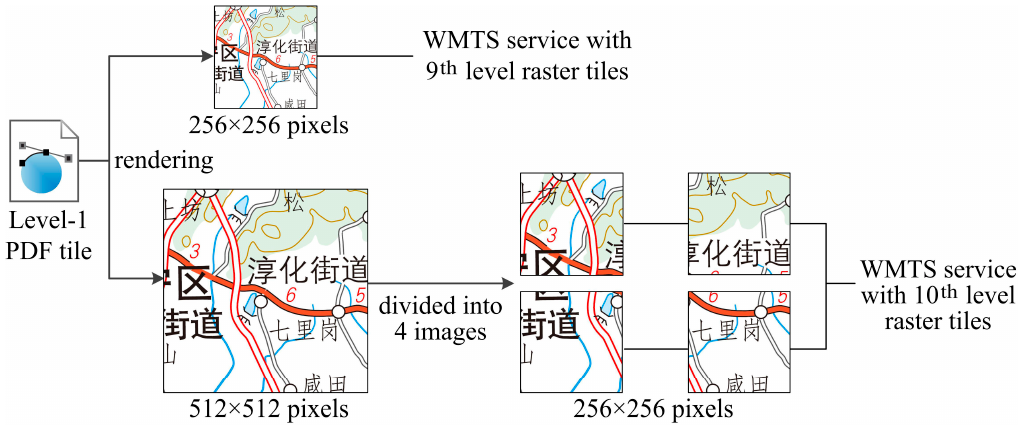
Figure 20. Rendering a level-1 PDF tile into 9 th and 10 th level raster tiles. WMTS (web map tile